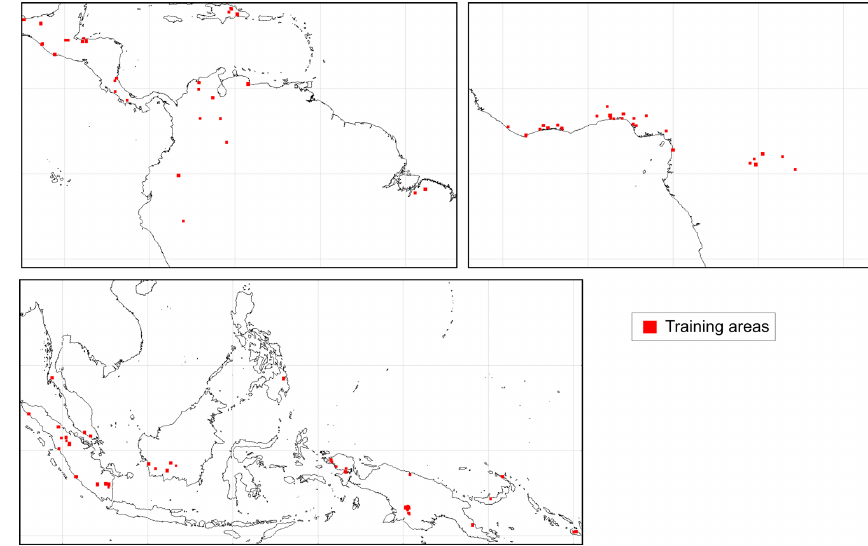
Figure A3. Location of areas where Sentinel-1 and Sentinel-2 was collected for training the convolutional neural network.